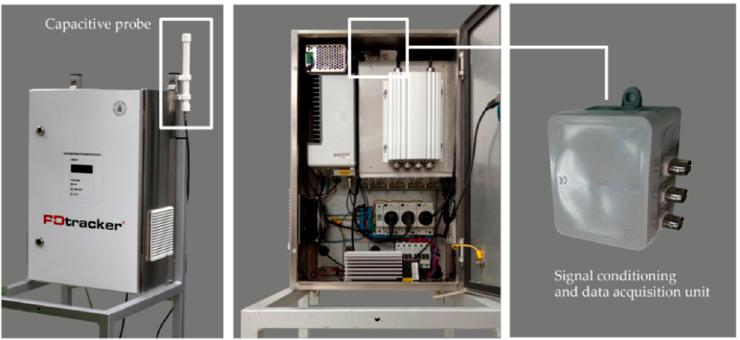
Figure 8. Photo of the online PD monitoring system and the components of the non-contact high voltage measurement module.